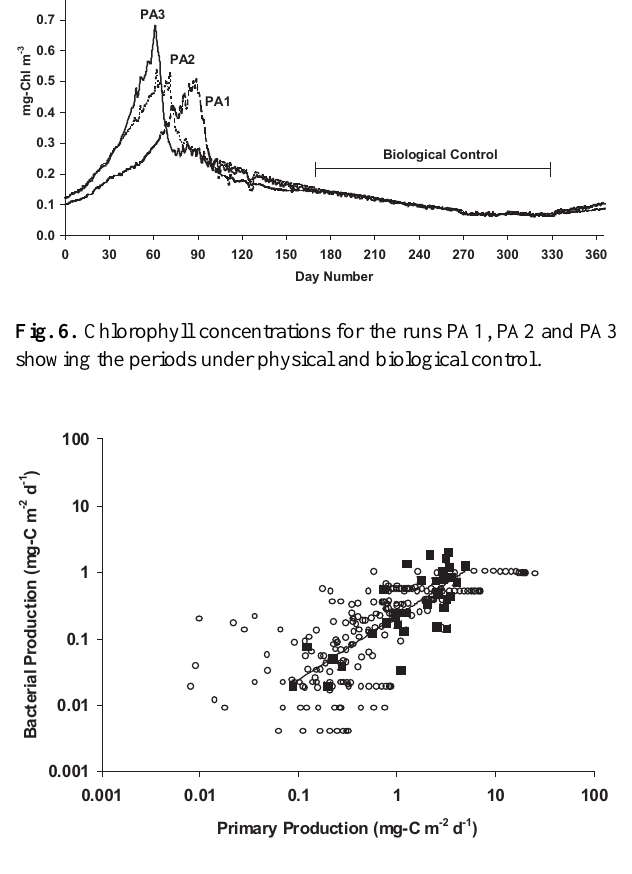
Fig. 7. Logged bacterial against primary production rates. Data taken in the eastern Mediterranean (Turley, 2000) (closed squares) and model output for the standard PA3 run (open circles). Model output taken every 30 days from the surface 100m. The line shows the best fit for the Turley data.